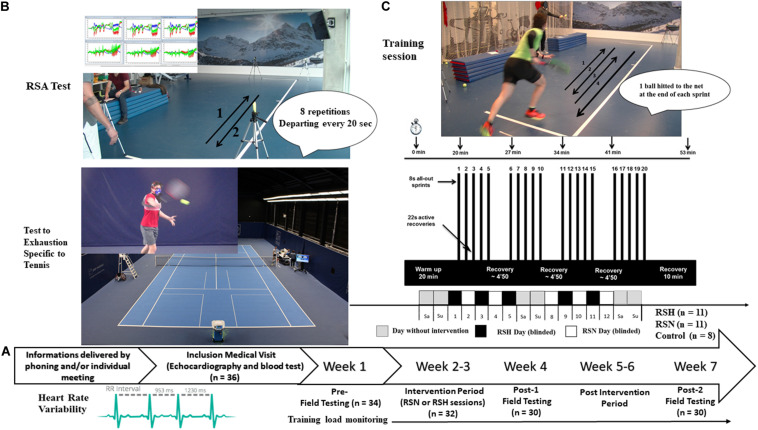
Protocol overview. General procedure (A), and description of a typical repeated-sprint training sessions, in normoxia (RSN) or hypoxia (RSH) (C). Field testing including repeated-sprint ability (RSA), Test to Exhaustion Specific to Tennis, heart rate variability (B), before the training intervention period (Pre-), during the week after (Post-1), and Post-2, 3 weeks after termination of Post-1.